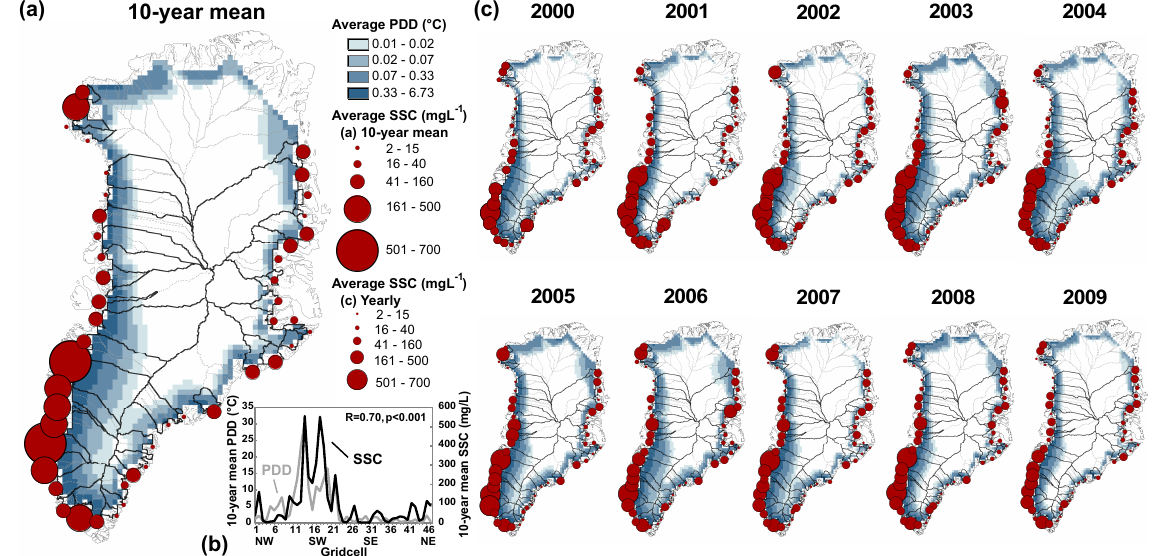
Fig. 5. (a) Map of 10yr mean ice sheet PDD (blue) and fjord plume SSC (red circles). (b) Spatial variation of 1yr mean PDD (grey line) and SSC (black line), starting in the northwest and going counterclockwise towards the northeast ( R = 0 . 70, p < 0 . 001). (c) Map of mean yearly SSC (red circles) and PDD (blue) for